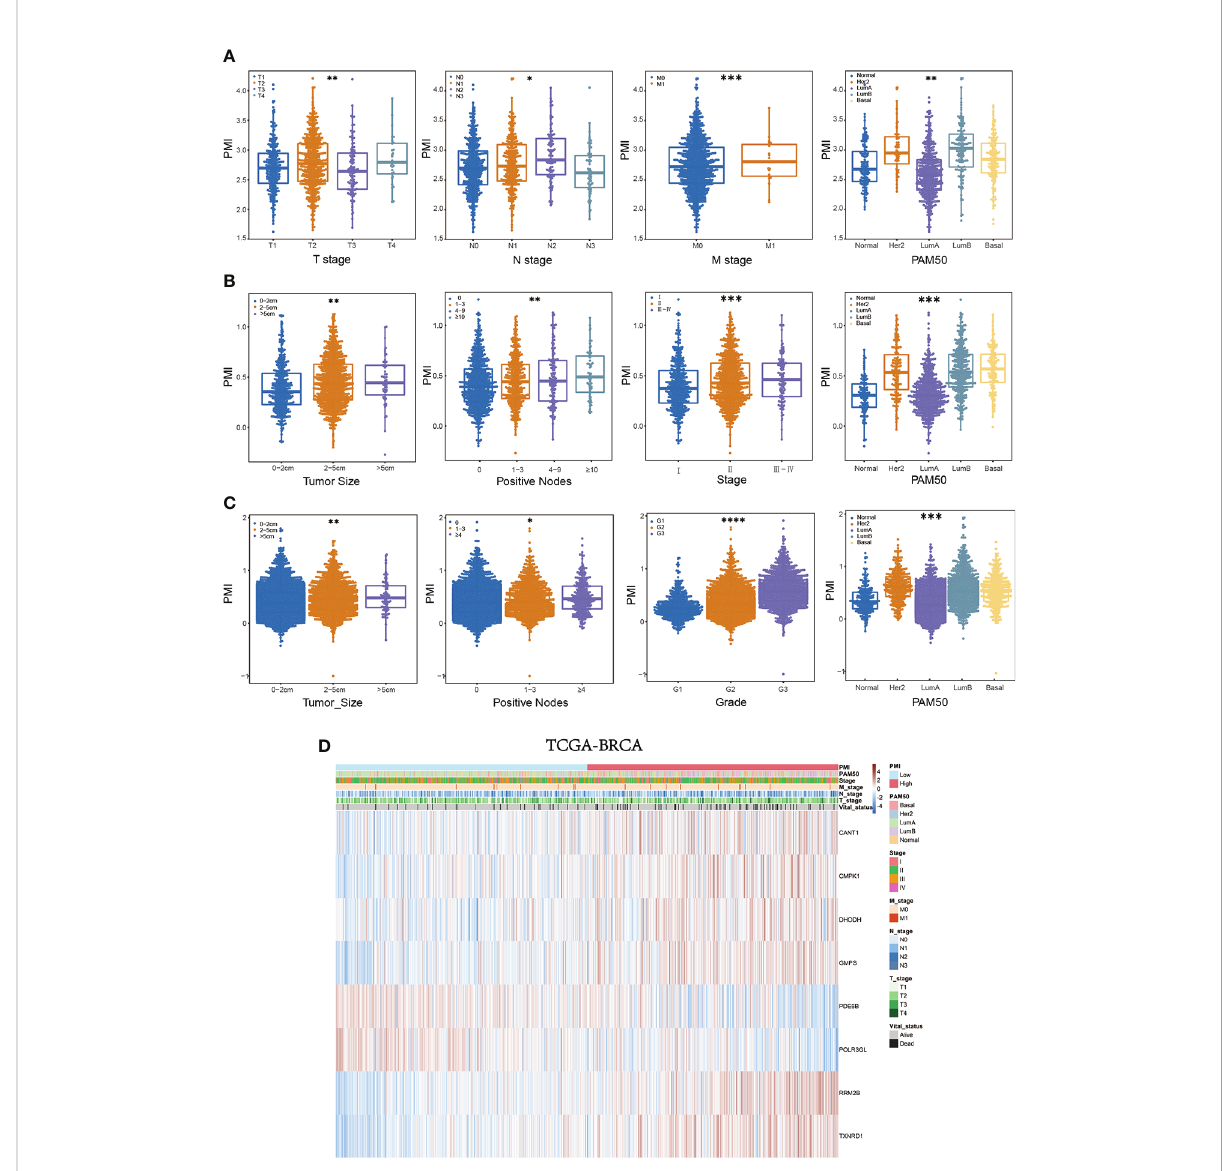
FIGURE 7 Systematic characterization of PMI and clinical variables among BC patients. (A – C) Beeswarm plots demonstrating the correlation between PMI levels and various degrees of diverse clinicopathological indicators in TCGA-BRCA (A) , METABRIC (B) , and GSE96058 (C) datasets. (D)